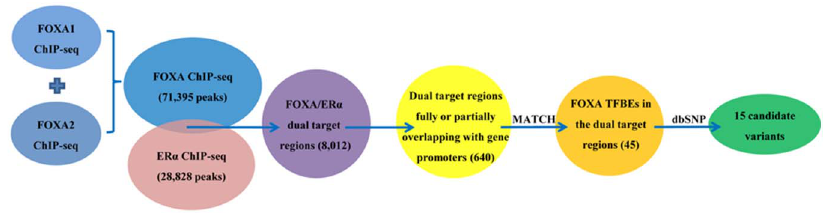
Figure 1. A computational strategy for identifying candidate variants at FOXA1/2 binding elements.